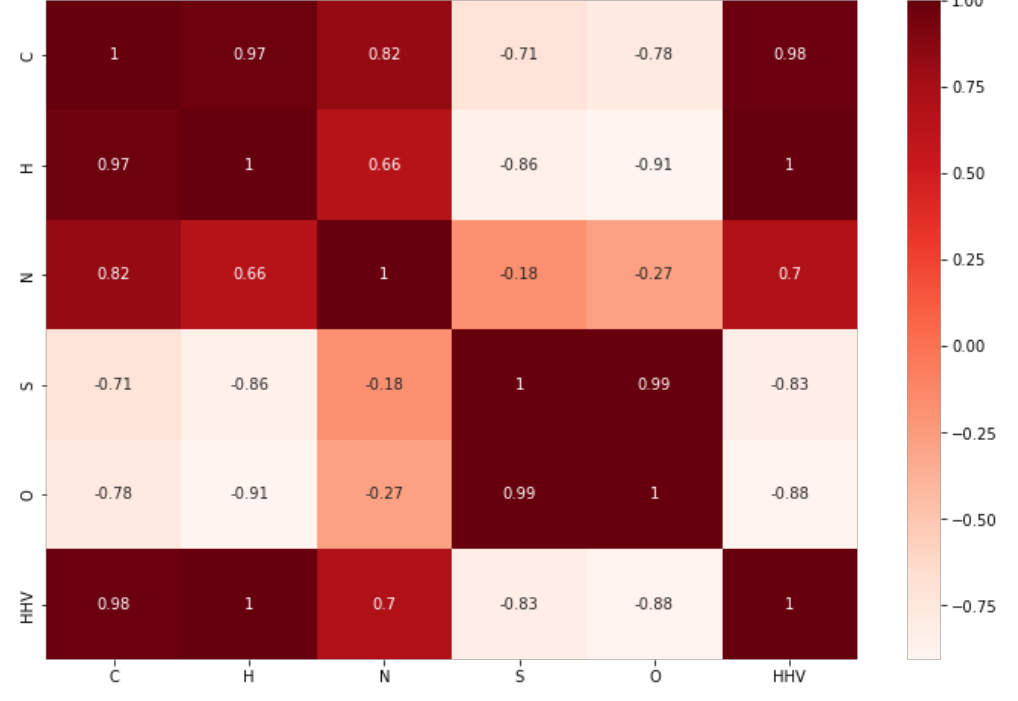
Figure 1. Correlation plot of observed variables of ultimate analysis and HHV.